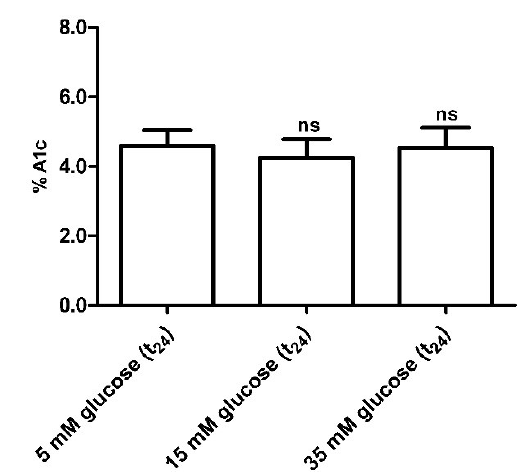
Figure 8. Glycated hemoglobin measurement in glucose-treated erythrocytes incubated for 24 h at different glucose concentrations (5-15-35 mM). ns (not significant) versus 5 mM glucose (t24) (control) as determined by one-way ANOVA followed by Bonferroni’s post-hoc test ( n = 10).